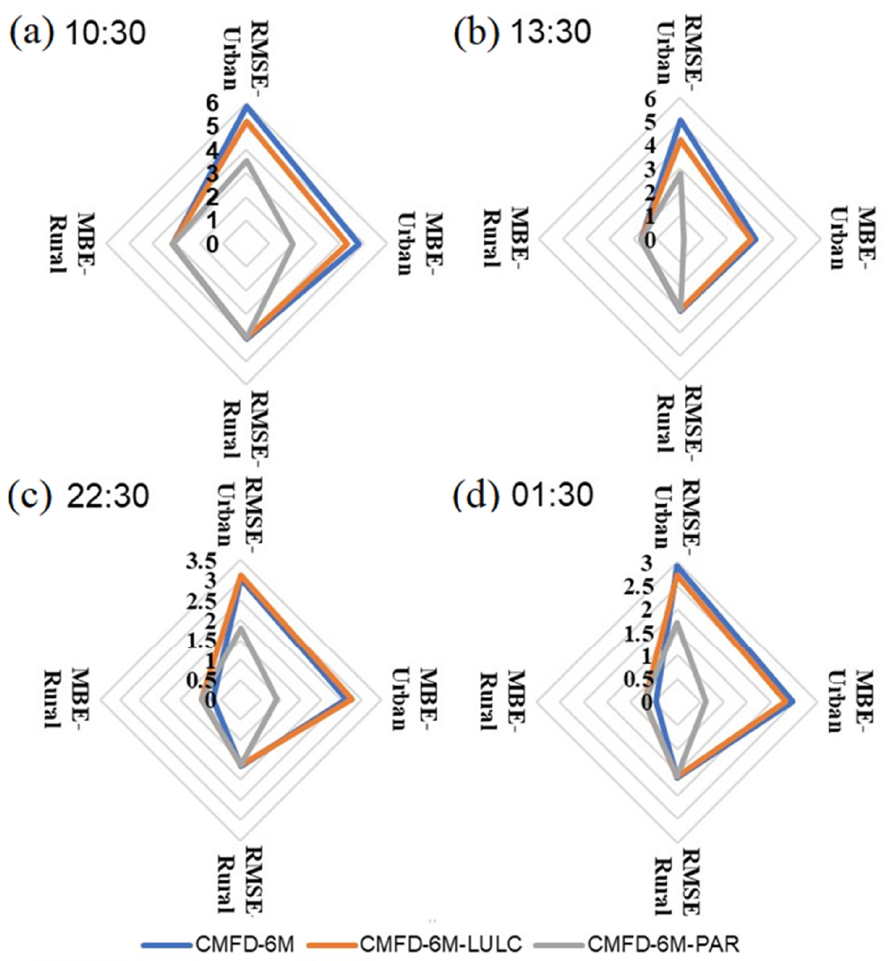
Figure 4. Comparison of simulated accuracy in CMFD-6M, CMFD-6M-LULC, and CMFD-6M-PAR (Unit: K), the subfigures ( a – d ) are for the local time of 10:30, 13.30, 22.30 and 01:30 respectively.